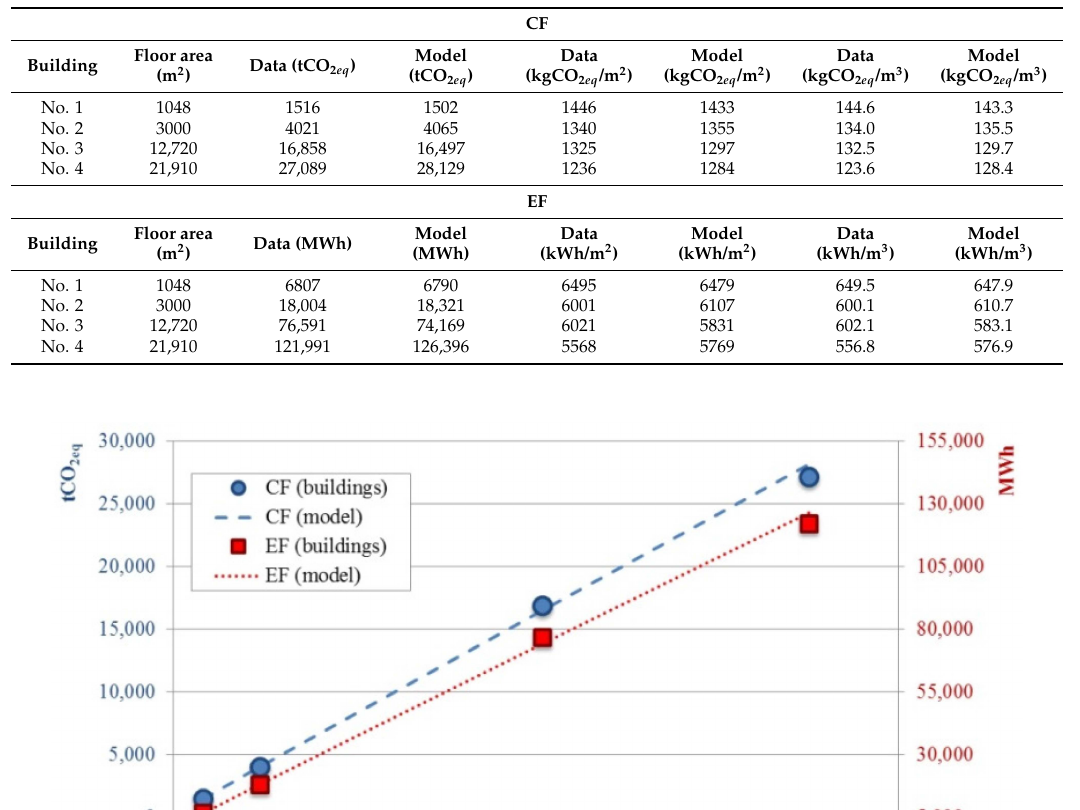
Table 4. Carbon and Energy footprint comparison of the four selected buildings (data) vs . the model for the reference scenario.